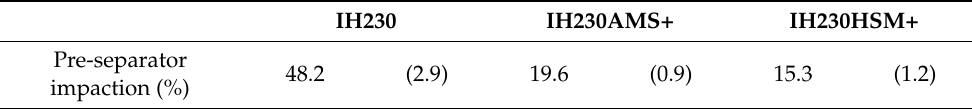
Table 7. Share of the recovered dose that impacted in the pre-separator of the FSI. n = 5, SD in